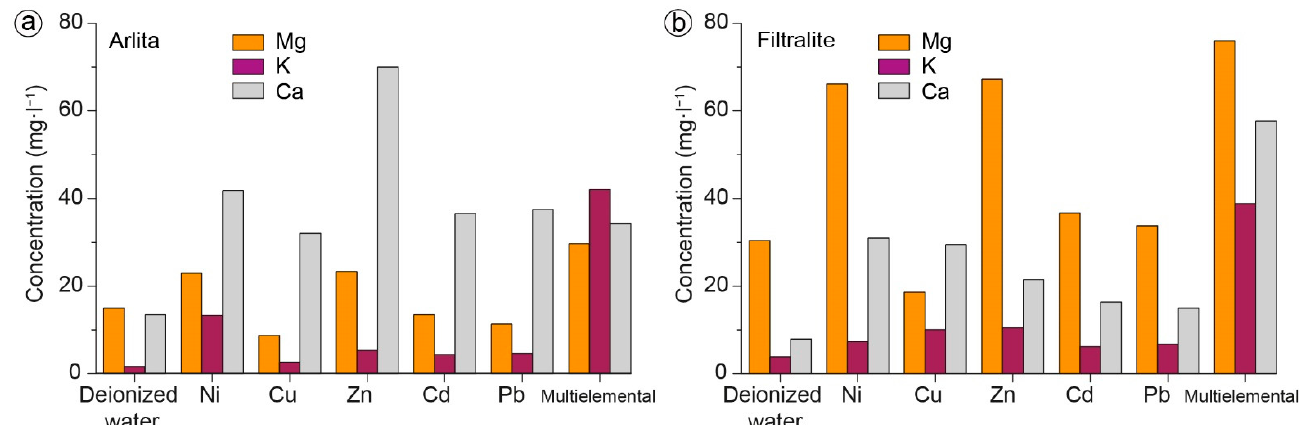
Figure 5. Final concentration equilibrium (Ce) for Mg, K, and Ca in the batch tests with deionized water and contaminated solutions (individual and multiple contaminants) employing Arlita ( a ) and Filtralite ( b ). The figure shows average results from five batch tests performed with 10 g of material and concentrations ranging from 50 to 500 mg·L − 1 (Ni), 2.5 to 25 mg·L − 1 (Cu), 25 to 250 mg·L − 1 (Zn), 15 to 150 mg·L − 1 (Cd), and 5 to 50 mg·L − 1 (Pb).